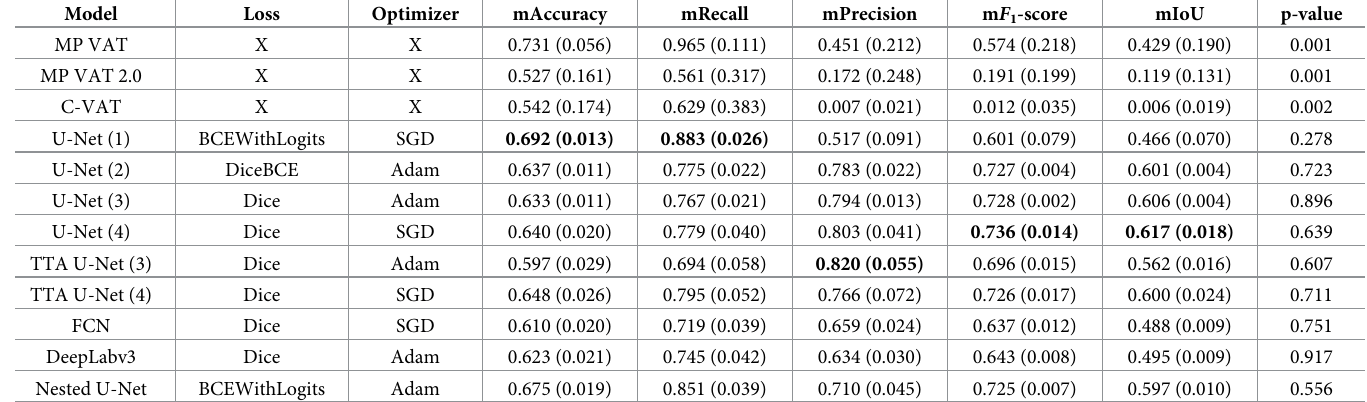
Table 4. Performance results obtained for Dataset B. The numbers between parentheses are standard deviations. The last column contains the p-values of the t-test com- paring the mean MP pixel count between ground truth and predicted masks.